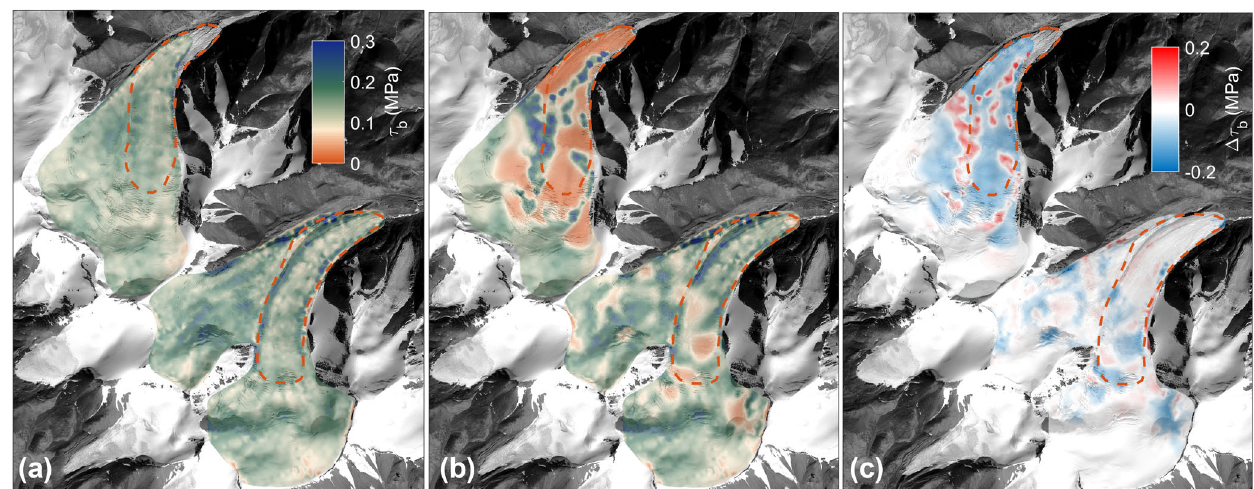
Figure 8. Modelled basal shear stress at steady state (a) and in November 2015 (b) . Panel (c) is the difference between (b) and (a) .